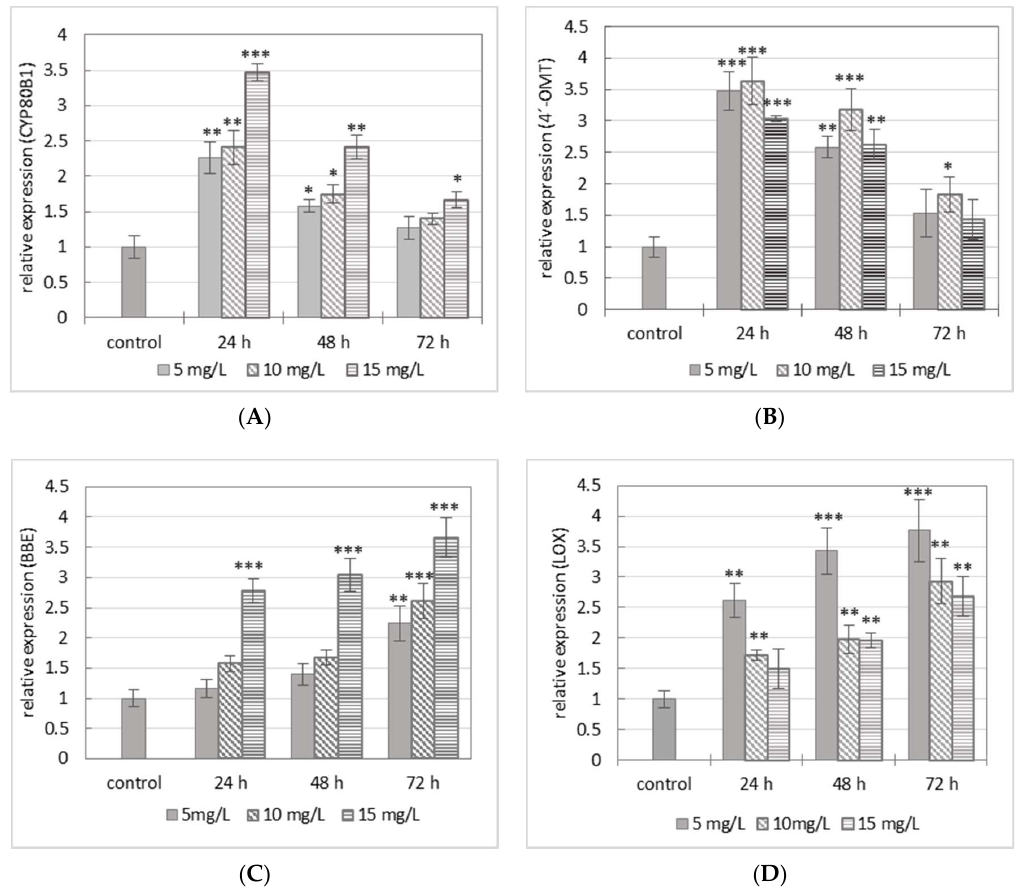
Figure 3. Manganese-chloride-induced expressions of CYP80B1 ( A ); 4′-OMT ( B ); BBE ( C ); and LOX ( D ) genes in cell suspension cultures of California poppy. The relative expression level shows the values standardized by that of the control (non-elicited sample) as 1. Values are means ± S.D from triplicate experiments ( n = 3). * p ≤0.05, ** p ≤0.01, *** p ≤ 0.001.